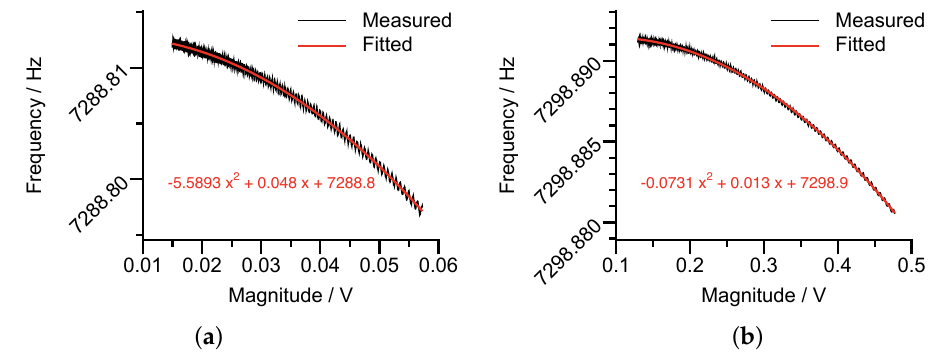
Figure 18. The measured nonlinear stiffness coefficients of the p mode ( a ) and the q mode ( b ).